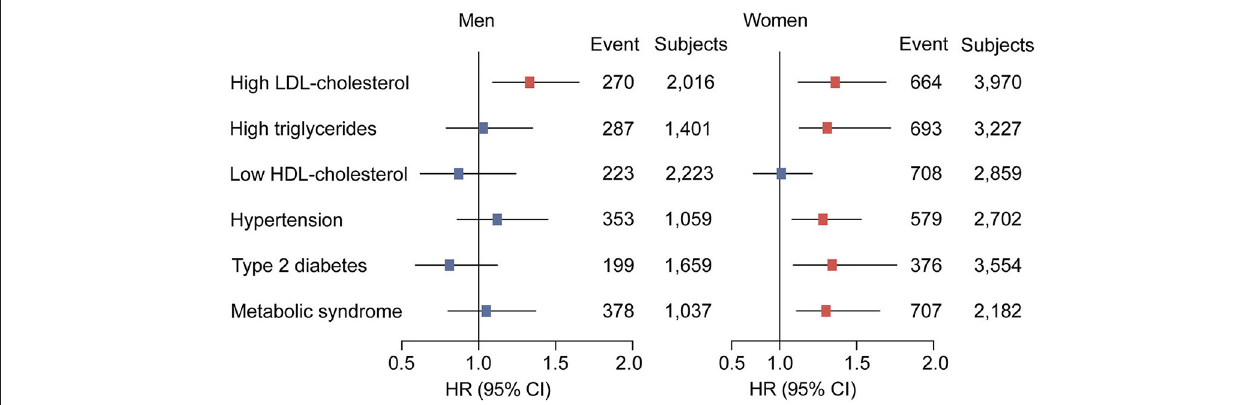
FIGURE 2 | Adjusted hazard ratios (HRs) of cardiometabolic risk factors according to per 1-SD increment in baseline circulating PCSK9 levels in men and women. Model was adjusted for age, current smoking status, alcohol consumption, physical activity, educational attainment, BMI, waist circumference, C-reactive protein, fasting plasma glucose, post-loading plasma glucose, HOMA-IR, systolic blood pressure, diastolic blood pressure, and lipid profiles. Subgroup variable was excluded from the model.